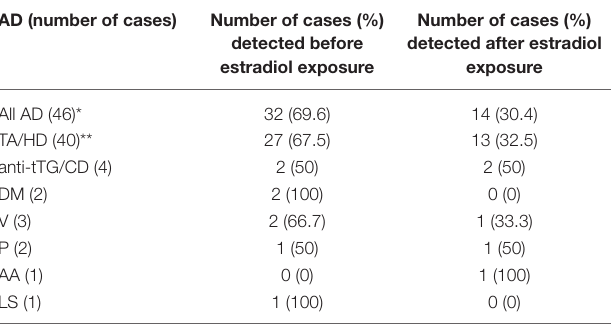
TABLE 3 | Occurrence of autoimmune diseases depending on estradiol